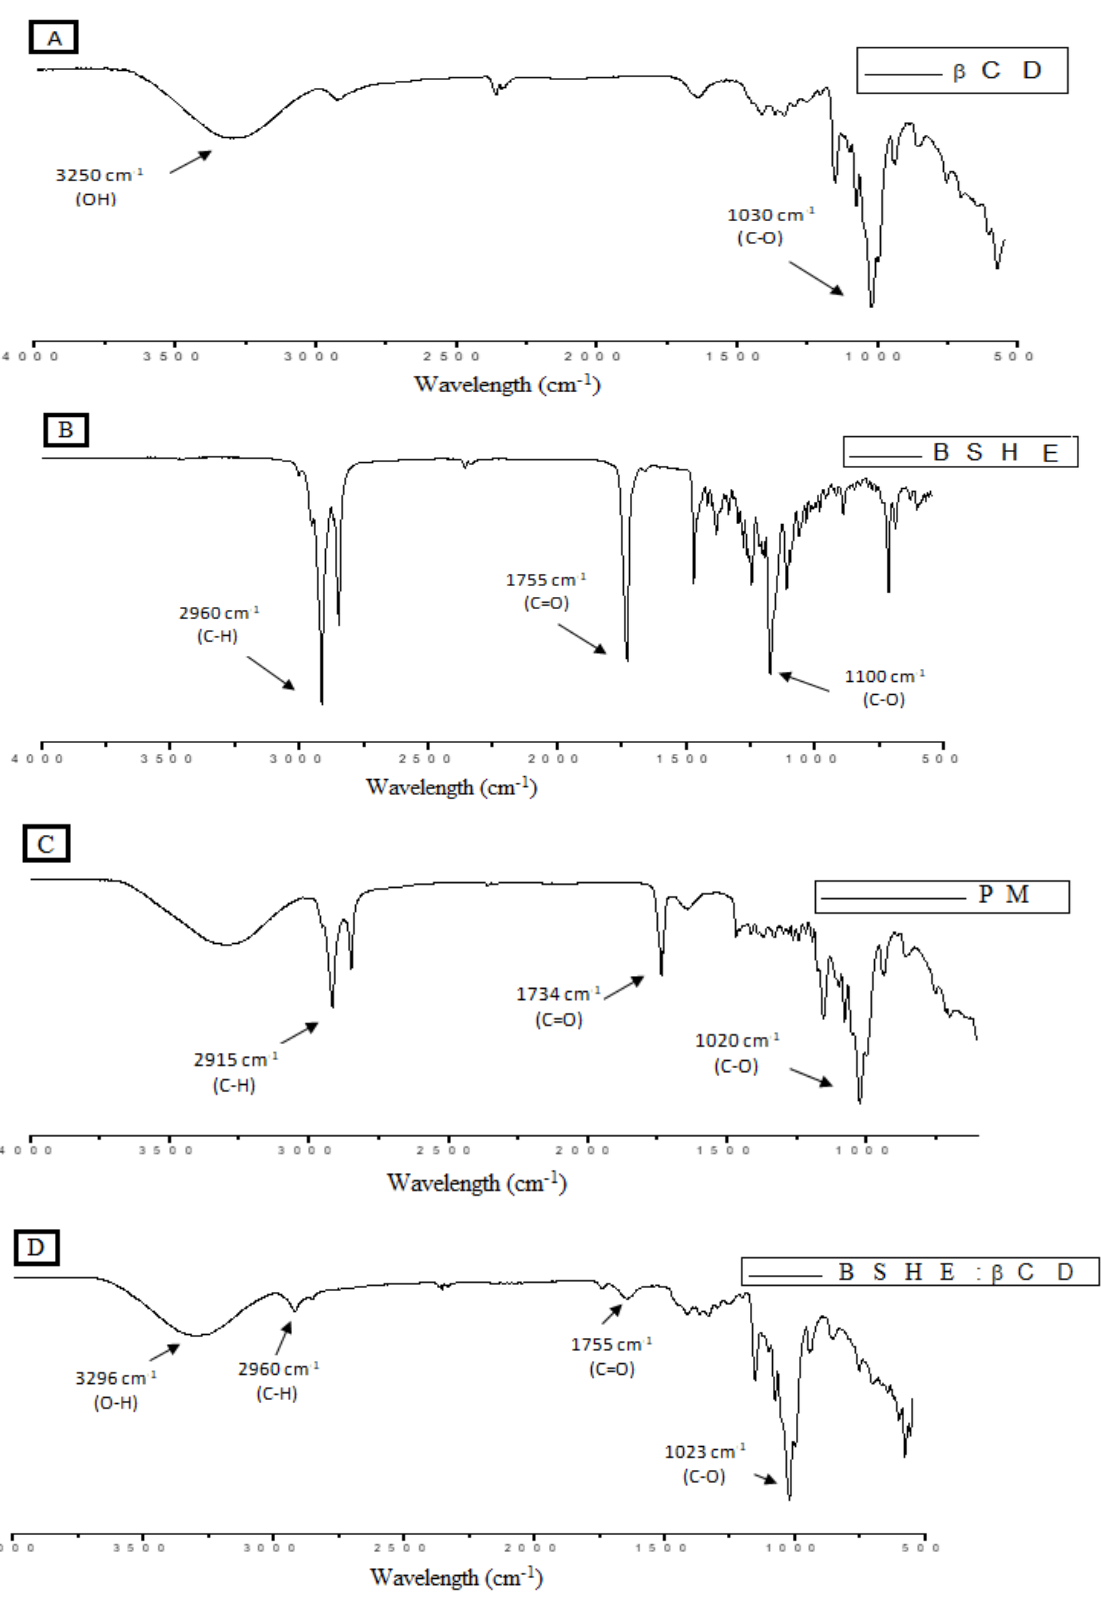
Figure 4. Infrared spectrum of samples containing BSHE and β‐ CD. ( A ) β‐ cyclodextrin molecule, ( B ) bacuri seed hexane extract (BSHE), ( C ) physical mixture between BSHE: β‐ CD, and ( D ) BSHE: β‐ CD inclusion complexes.